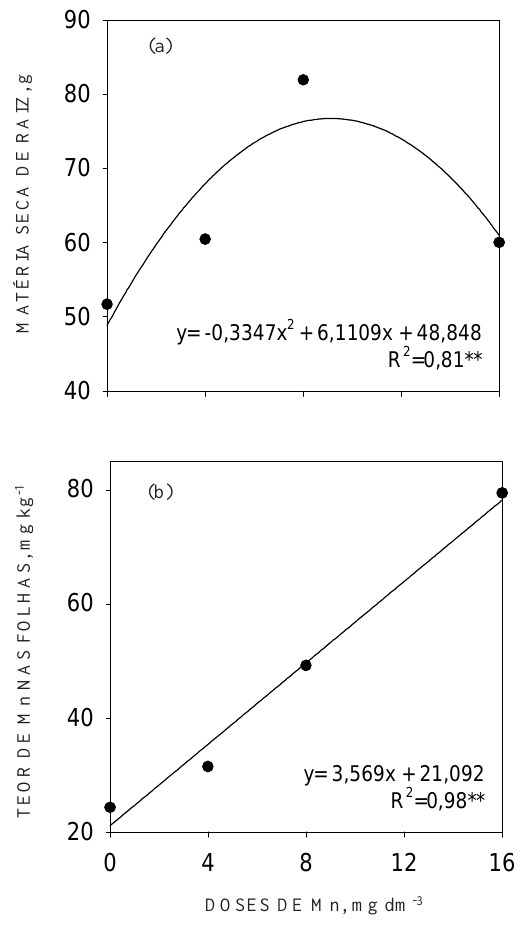
Figura 1. Matéria seca de raiz e teor foliar de Mn, considerando as doses de Mn aplicadas ao solo, para ambos os cultivares